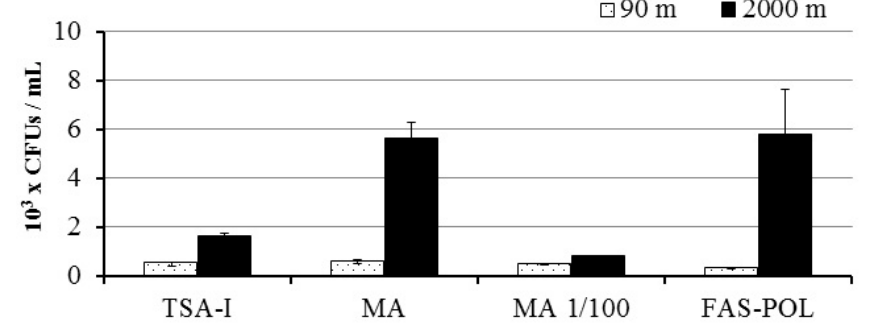
Figure 1. Cultivable bacteria concentration (colony forming units (CFU)/mL, average ± s.d., n = 5) obtained in the photic (90 m, white bars) and aphotic (2000 m, black bars) samples for the culture media TSA ‐ 1%NaCl (TSA ‐ 1), Marine Agar (MA), Marine agar diluted 1:100 in seawater (MA 1/100), and Filtered autoclaved sea ‐ water enriched with polymers (FAS ‐ POL).